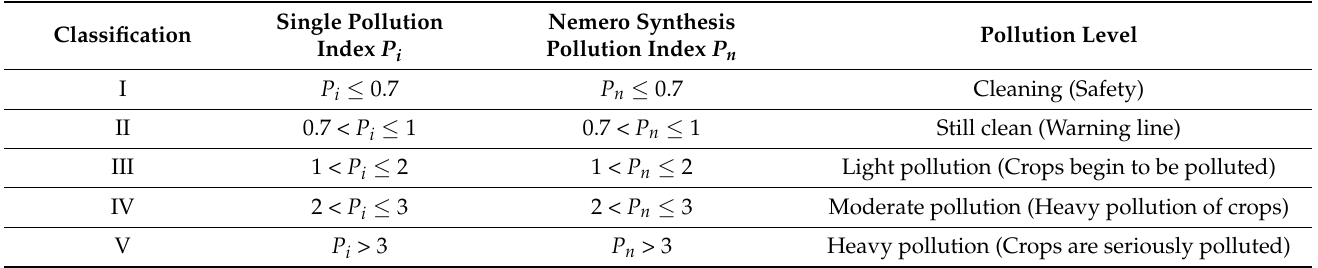
Table 3. Classification of soil heavy metal